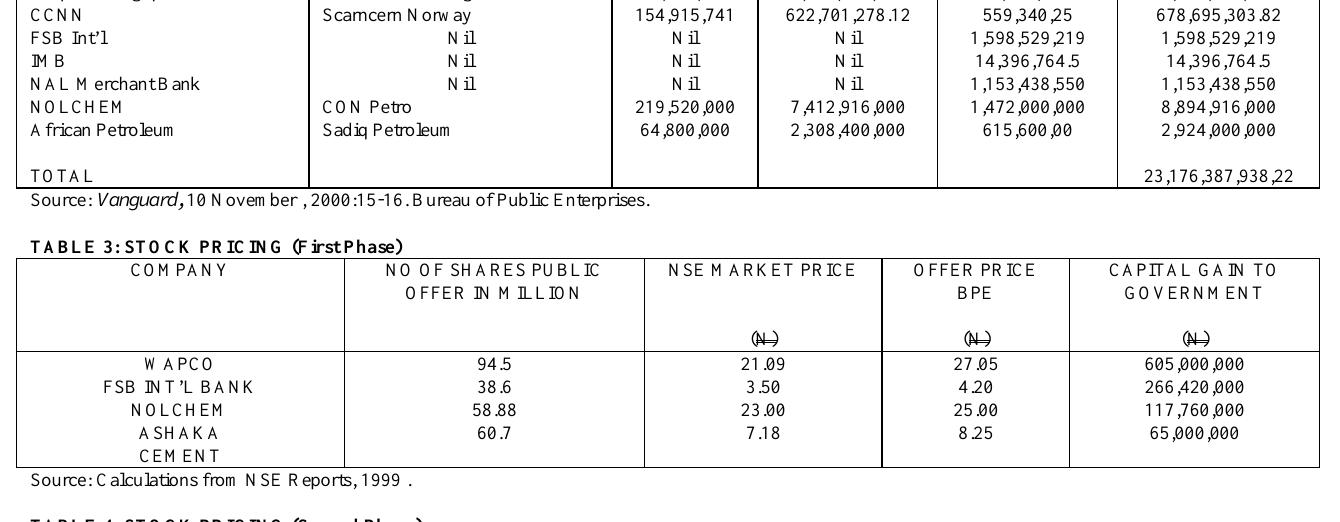
TABLE 4: STOCK PRICING (Second Phase) PRIVATISED